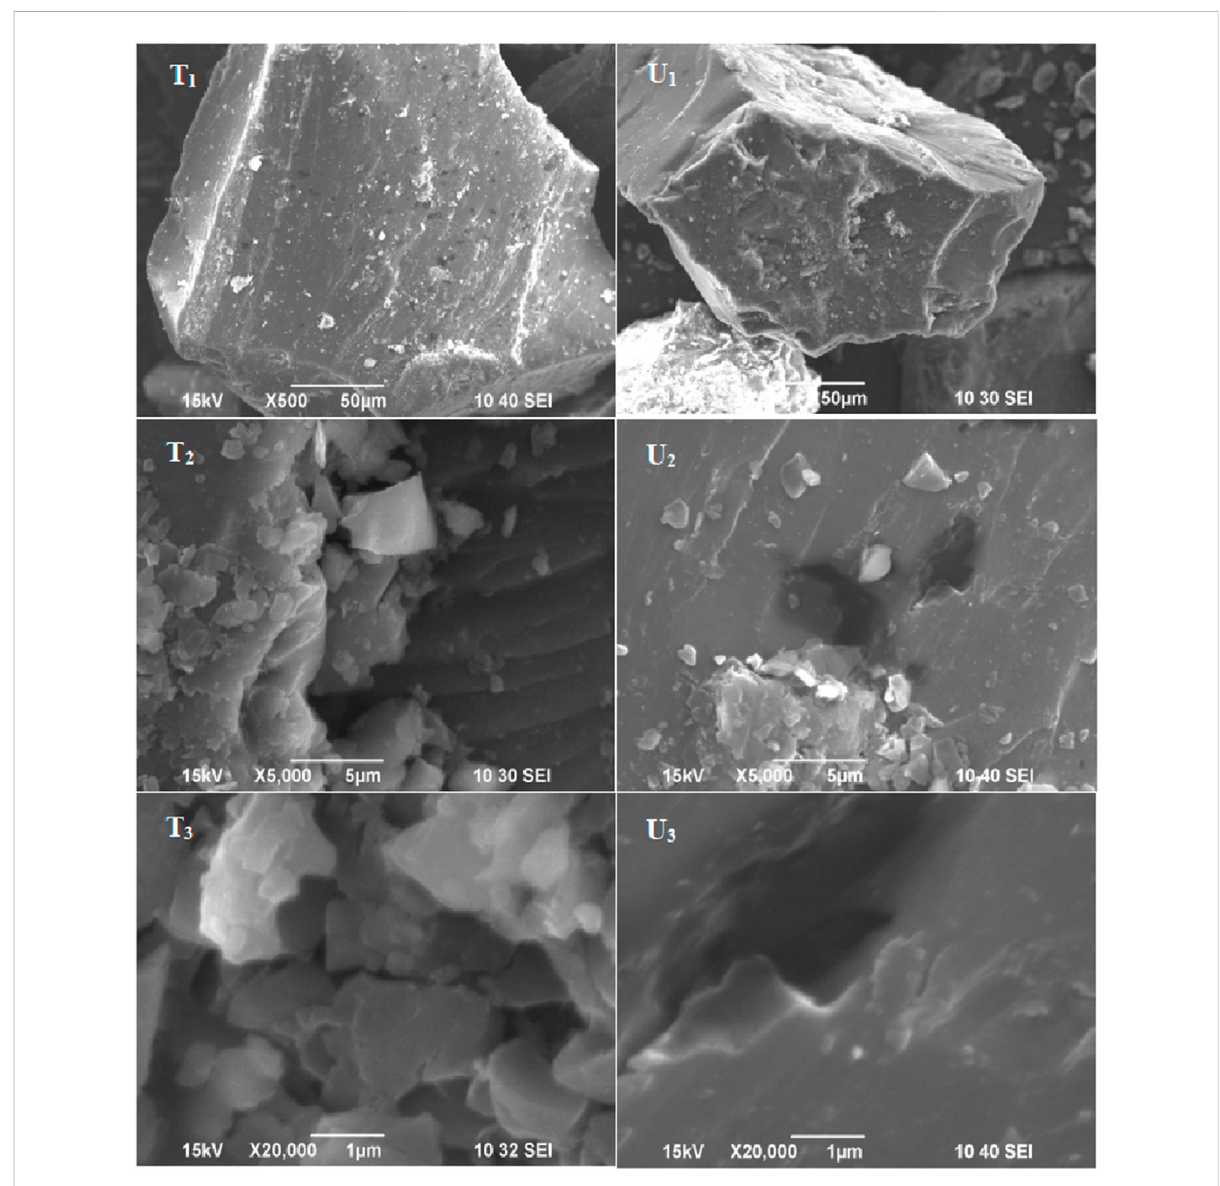
FIGURE 10 SEM images comparing morphological features of fat coal rank tectonic/untectonic coal (modi fi ed from Gao., 2011). Note: T 1 , T 2, and T 3 are tectonic coal samples; U 1 , U 2, and U 3 are untectonic coal